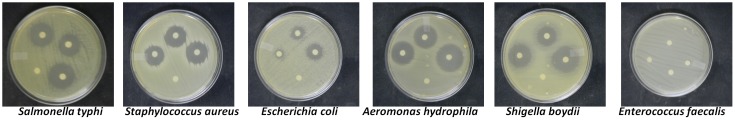
Antibacterial activity of crude compounds isolated from treated and untreated control cultures of Colletotrichum gloeosporioides.